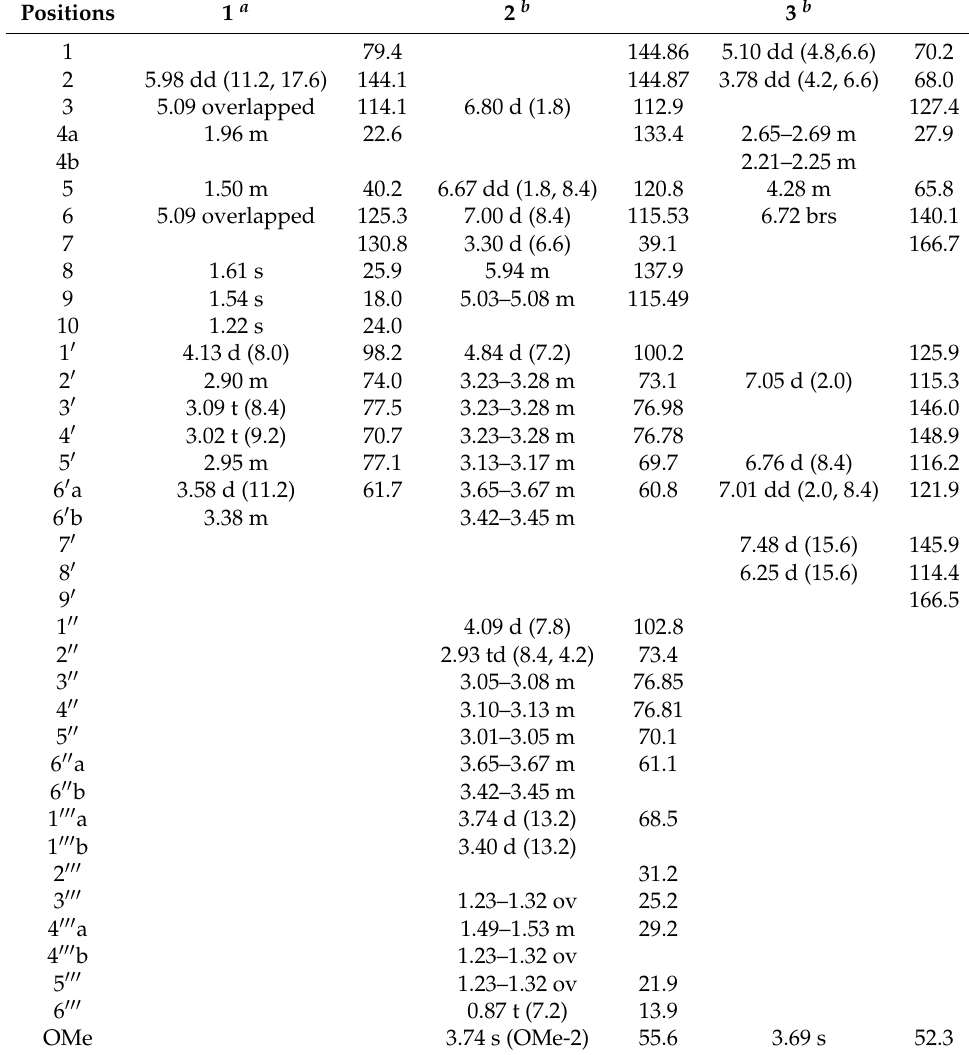
Table 1. 1 H and 13 C-NMR spectroscopic data of 1 – 3 (in DMSO- d 6 , TMS) ( δ in ppm, J in